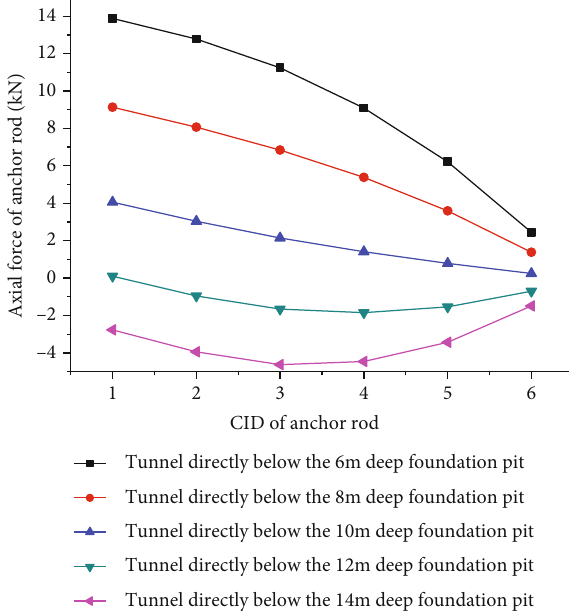
Figure 12: Axial force of the leftmost anchor rod in the foundation pit with 20m width and di ff erent depths.